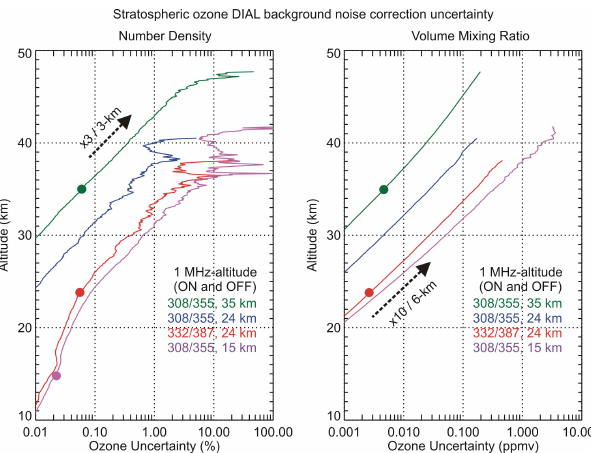
Figure 5. Ozone number density relative uncertainty (left) and ozone mixing ratio uncertainty (right) owing to background noise correction (linear fit) for stratospheric ozone DIAL systems of vary- ing performance. The systems’ performance is measured as the al- titude of 1MHz count rate for both the ON and OFF channels sig- nals, using typical nighttime background noise conditions. See text for details.